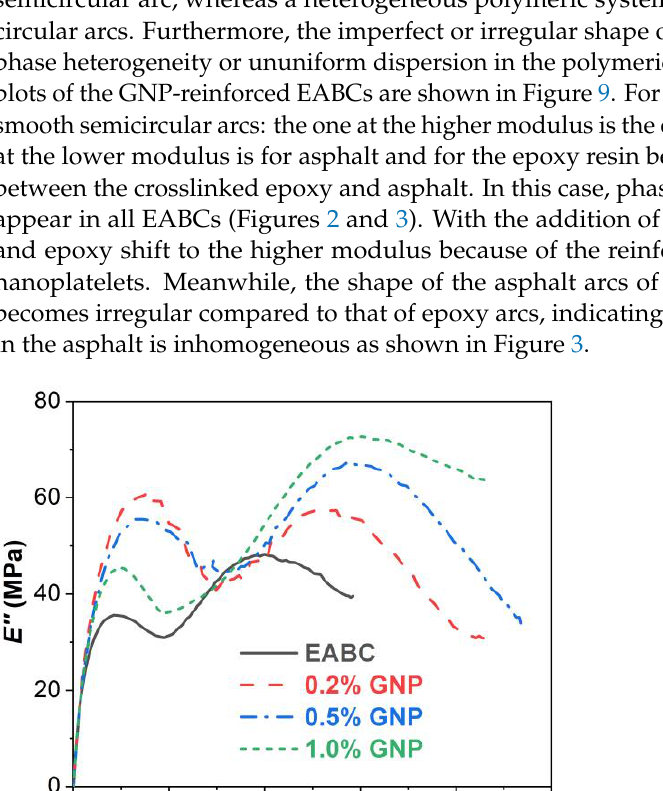
Figure 10. Tensile strength ( a ) and elongation at break ( b ) of GNP-reinforced EABCs. In a tensile test, the integral of the stress ( σ ) vs. strain ( ε ) curve indicates the toughness ( τ ) of the material [57,58]. Thus, 0 = b d      (4) where ε b is the elongation at break. To determine the brittleness ( B ) of polymeric materials, Brostow et al. [59] proposed an empirical equation: